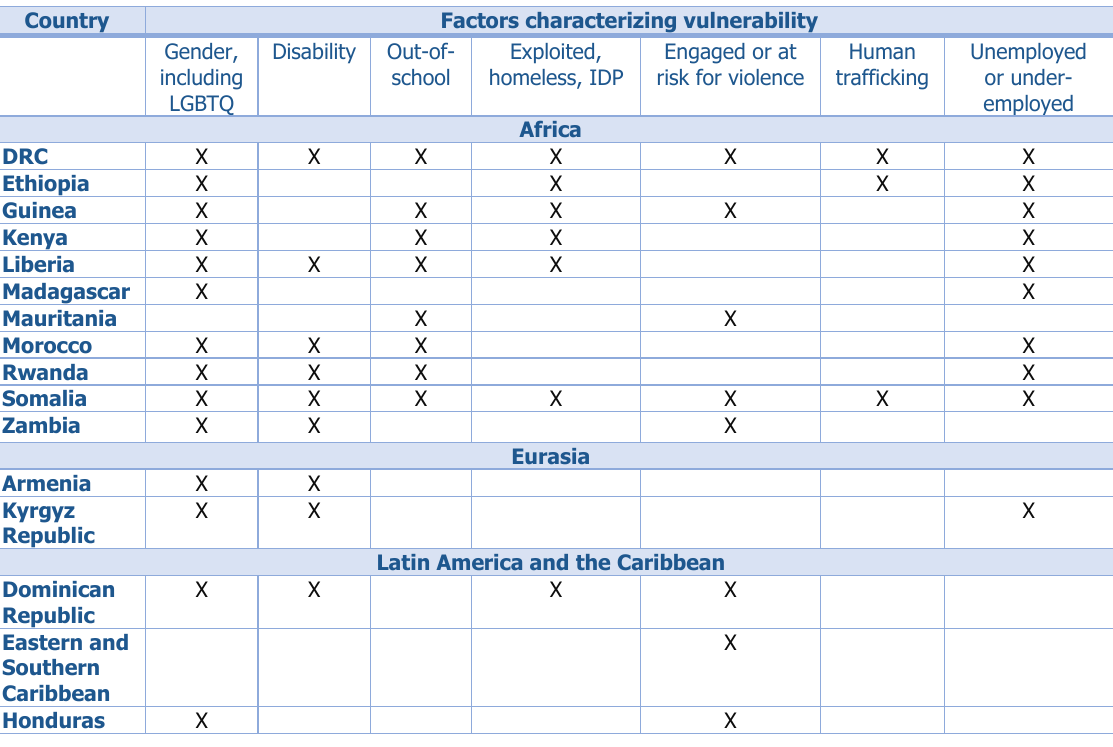
Table 3. Youth Segments Identified as